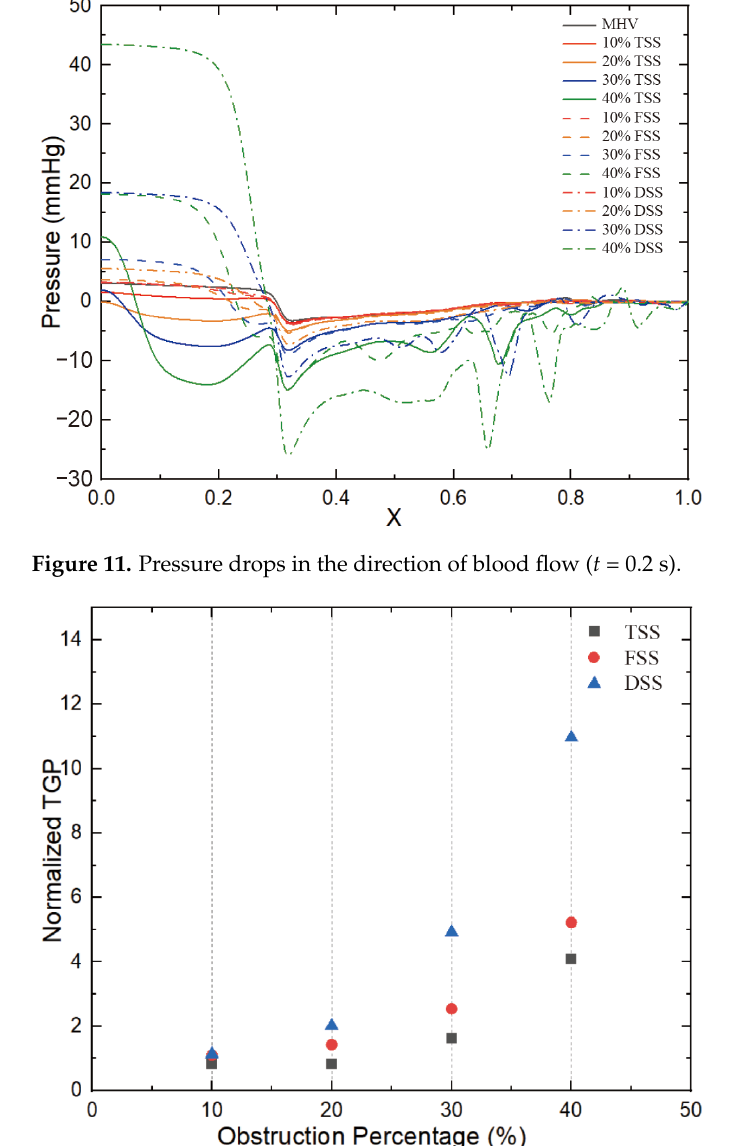
Figure 12. NTGP VS obstruction percentage ( t = 0.2 s).